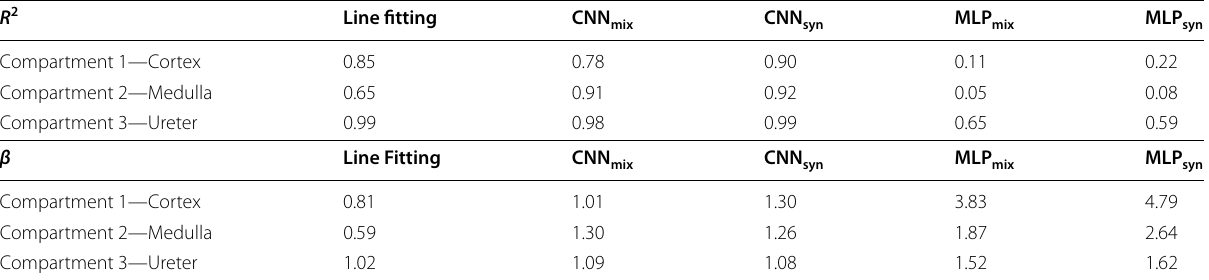
Both parameters show poor accuracy and strong prediction bias for the medulla for line fitting and MLP networks potentially due to low SNR